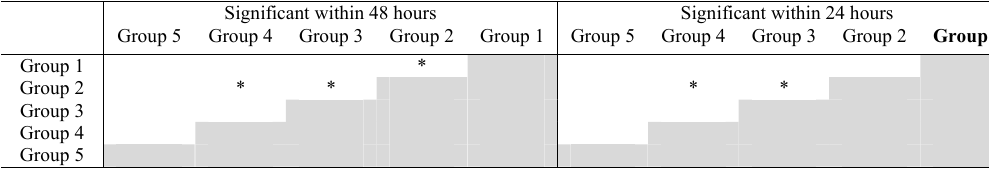
Table 3. Significance at concentration 0.5 at P<0.001 Table 3: Significance at concentration 0.5 at P<0.001